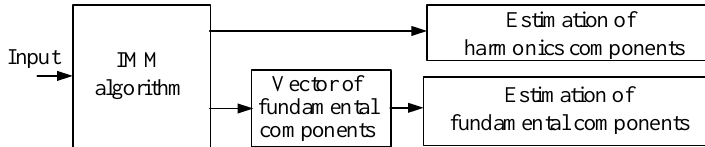
Figure 2. Proposed tracking method based on IMM algorithm.